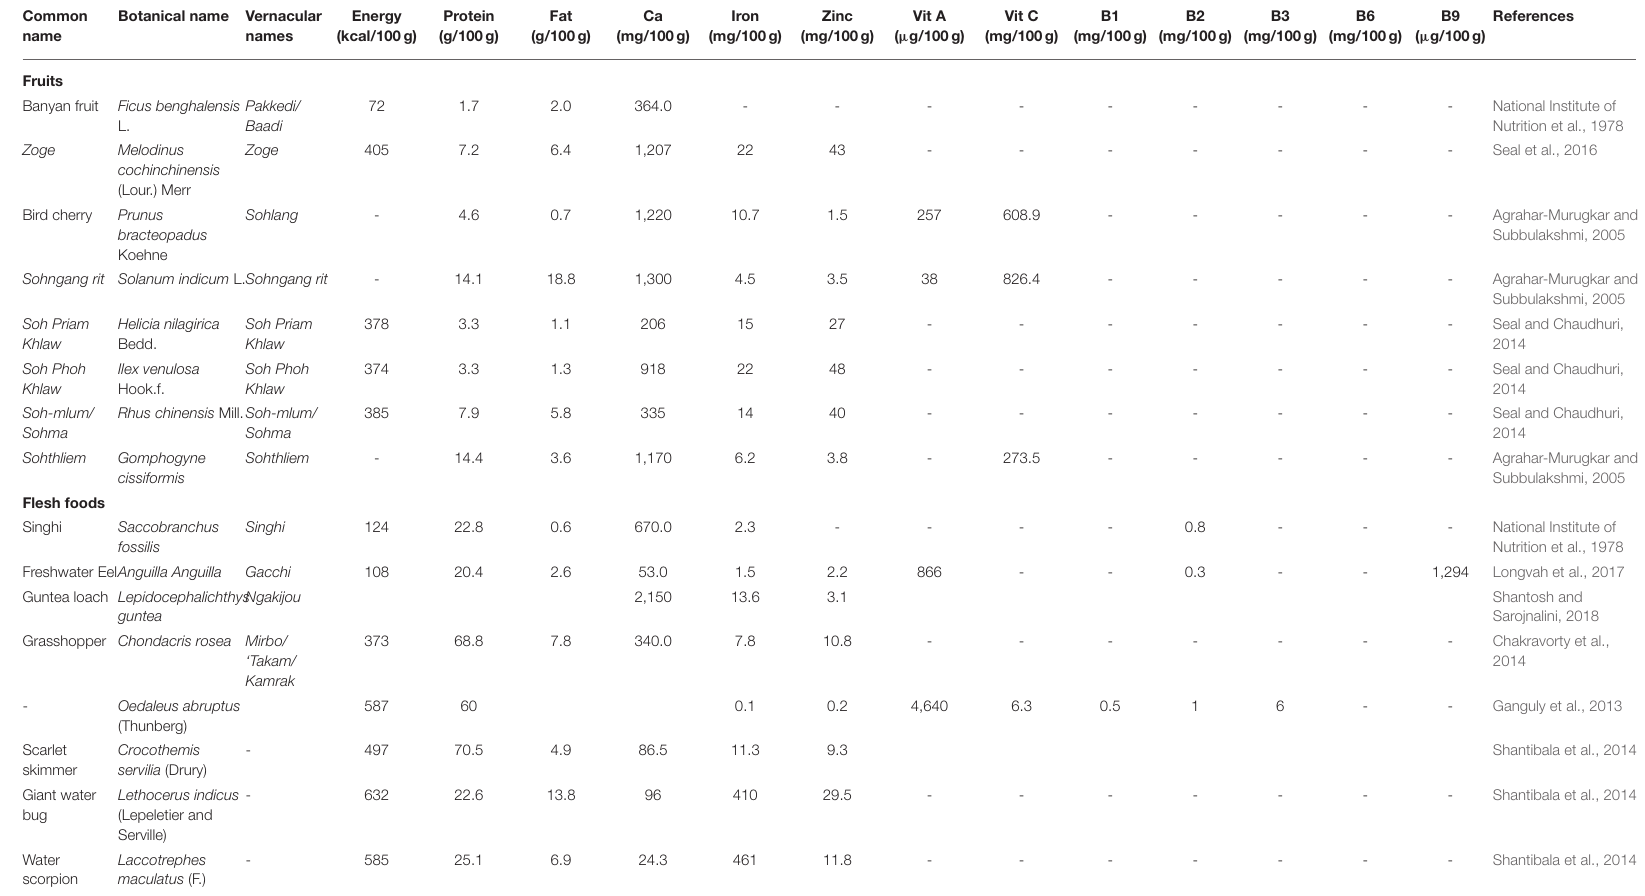
(Thunberg) Crocothemis servilia (Drury) Lethocerus indicus (Lepeletier and Serville) Laccotrephes maculatus